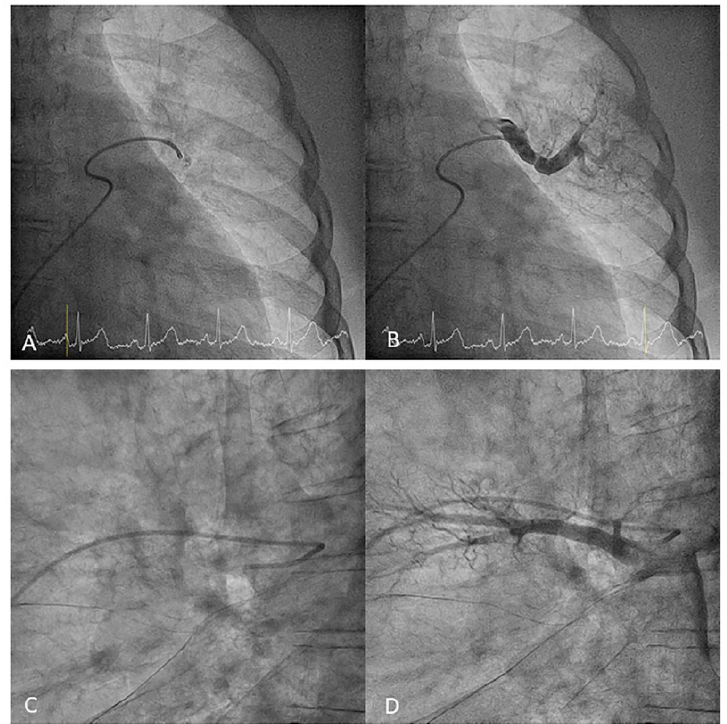
Figure 26. JL catheter position canulating the left upper lobe anterior segmental branch (A3), ( B , D ) with and ( A , C ) without contrast.